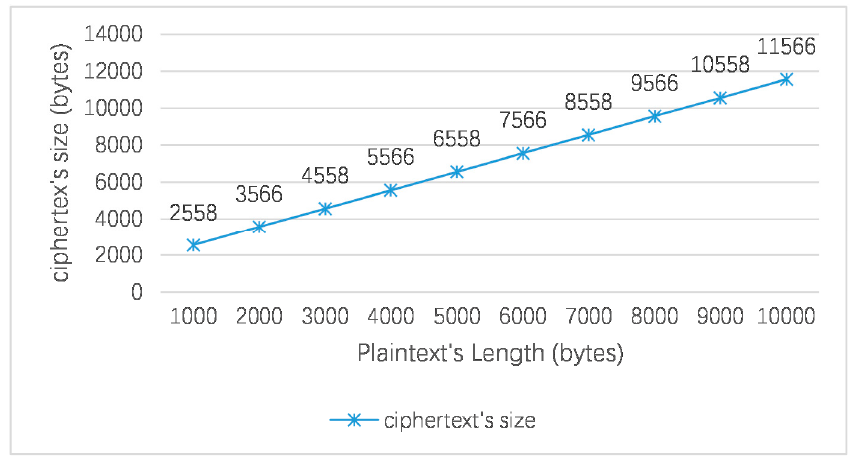
Figure 12. Hybrid ABE’s ciphertext’s size with respect to the access structure’s size (1 KB plaintext).